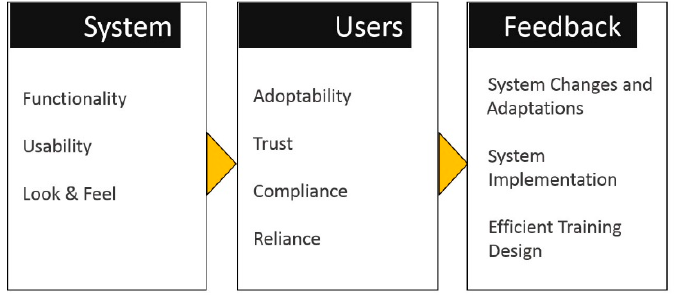
Figure 9. Summative assessment.